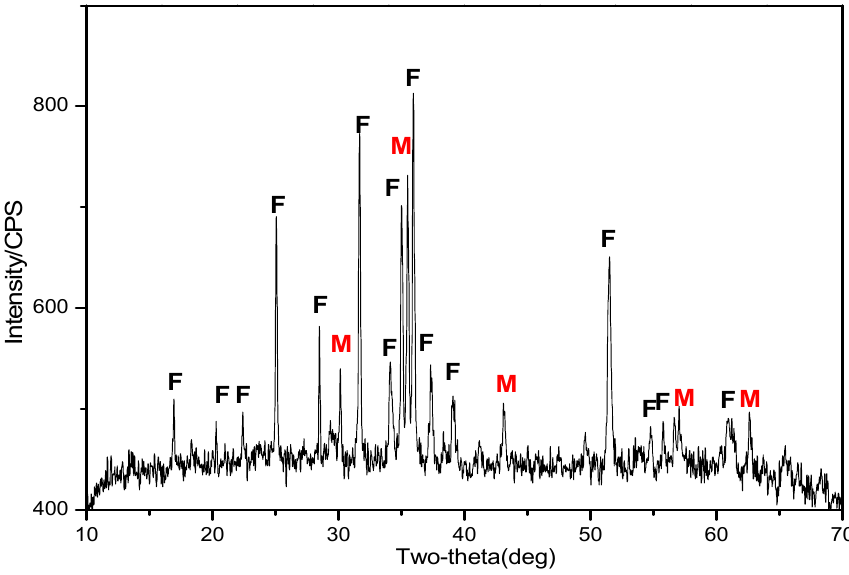
Figure 1. X-ray diffraction patterns of copper slag (F—fayalite; M—magnetite). Figure 1. X ‐ ray diffraction patterns of copper slag (F—fayalite; M—magnetite).